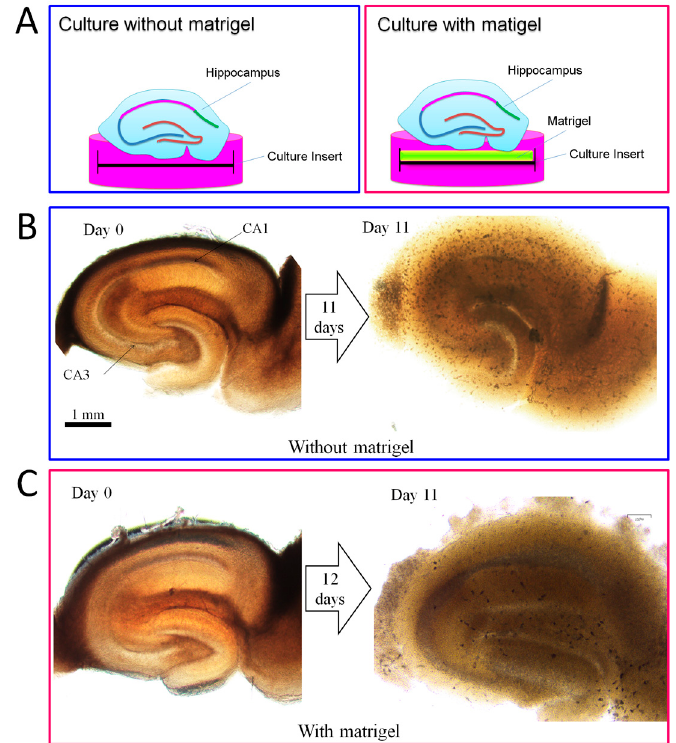
Figure 4. A novel method for long-term culture of adult mouse hippocampal slices in vitro. ( A ) Experimental setup; ( B ) Adult mouse hippocampal slices were cultivated on the culture insert without matrigel. After 11 days of cultivation, the CA1 and CA3 zones had disappeared; ( C ) Adult mouse hippocampal slices were cultivated on a matrigel-coated culture insert. After 11 days of cultivation, the CA1 and CA3 zones were still clear.